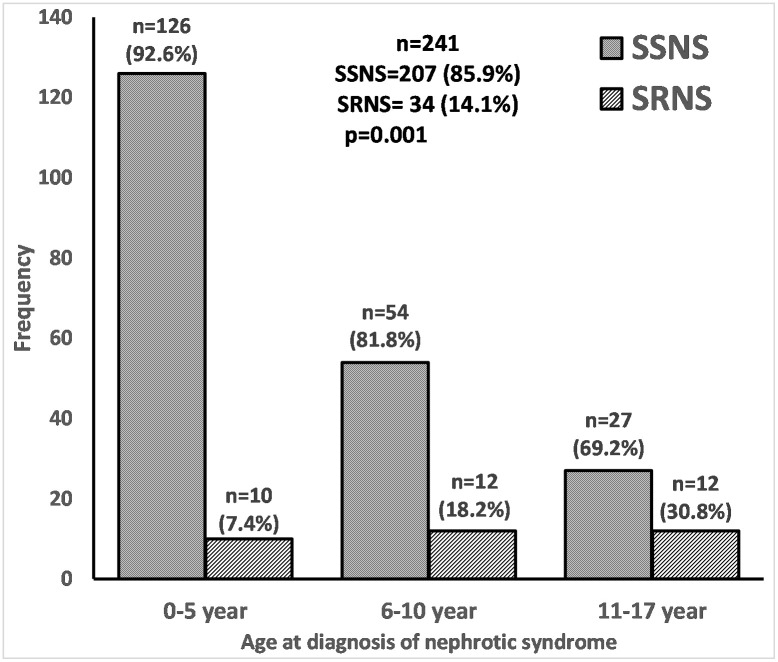
Distribution of steroid sensitive and resistant nephrotic syndrome with age.